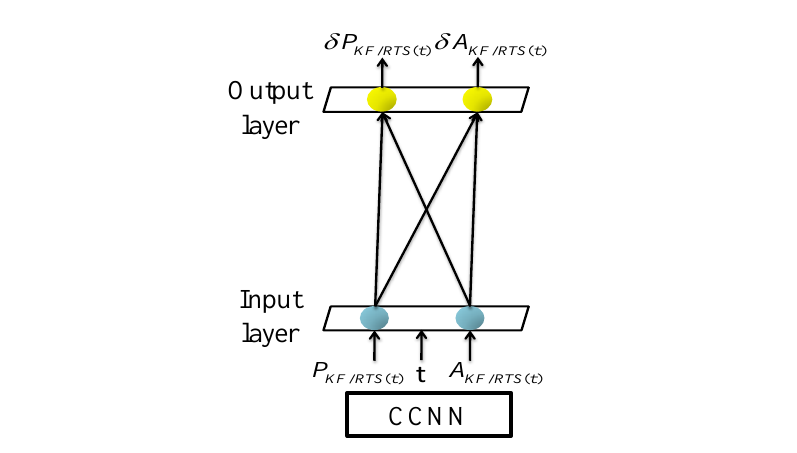
Figure 10. The initialization of a